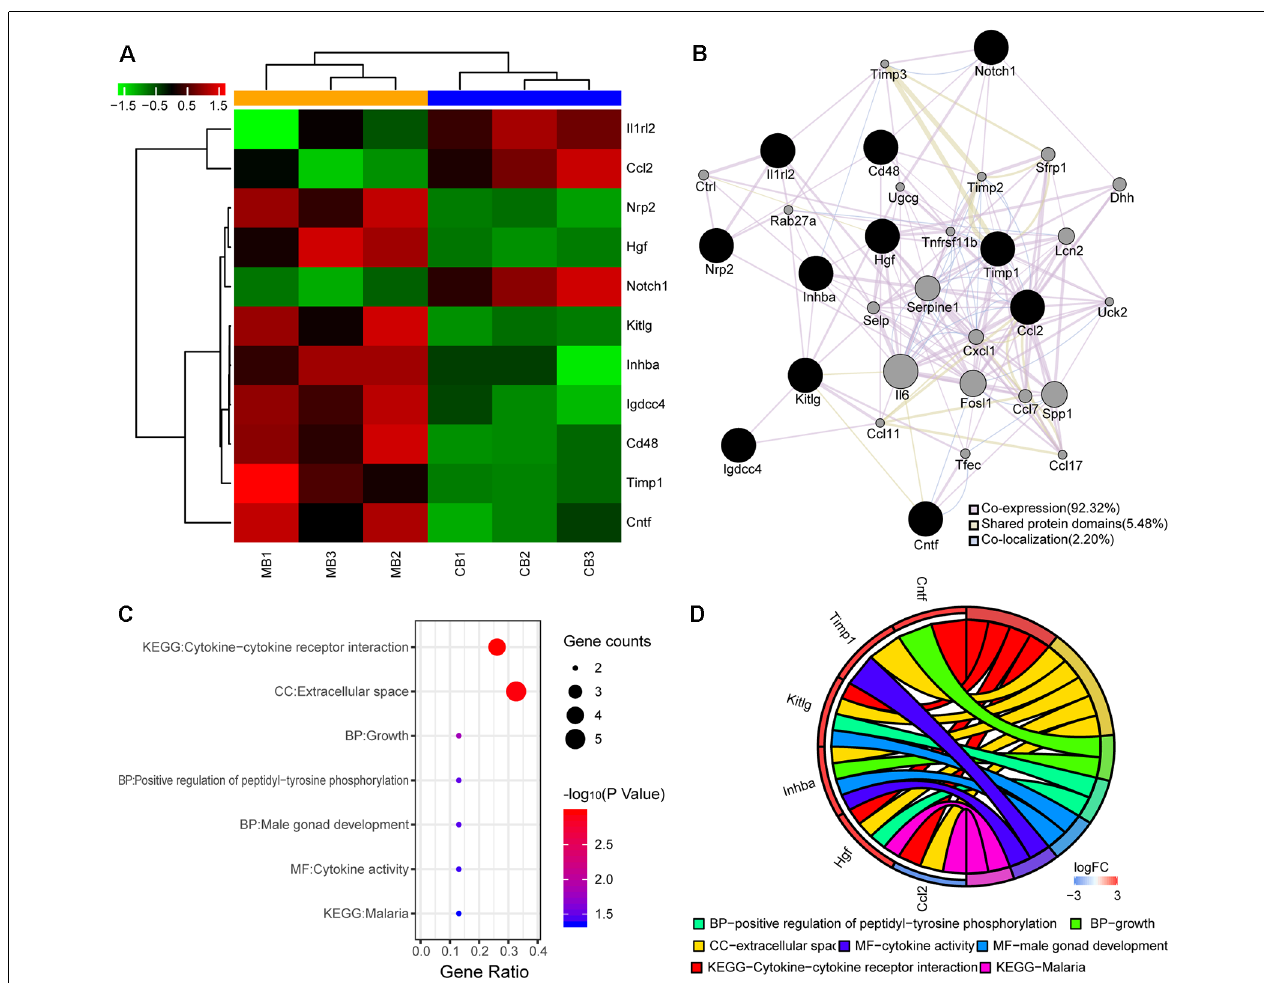
FIGURE 3 | Differentially expressed proteins and bioinformatics analyses. (A) Heatmap shows up- and downregulated proteins. The horizontal axis indicates the protein name. Red and green represent the up- and downregulated proteins, respectively. The colors of the nodes are illustrated from red to green (black in the middle) in descending order of log2 (fold-change). (B) Protein-protein interaction (PPI) network of the differentially expressed proteins. The sizes of the spots in the network represent the weights of the interaction. The black spots represent the differentially expressed proteins determined experimentally and the gray spots represent the proteins predicted by GeneMANIA. (C) Enrichment analysis of 11 genes from the PPI network is shown in the bubble plot. The colors of the nodes are illustrated from red to blue in descending order of –log10 ( P -value). The sizes of the nodes are illustrated from small to large in ascending order of gene counts. The horizontal axis represents the KEGG pathway and GO terms and the vertical axis represents the gene ratio. (D) The relationships among the top enriched KEGG pathway, GO terms, and differentially expressed genes in the PPI network. The relationships are represented by a chord plot in which genes are ordered according to their logFC